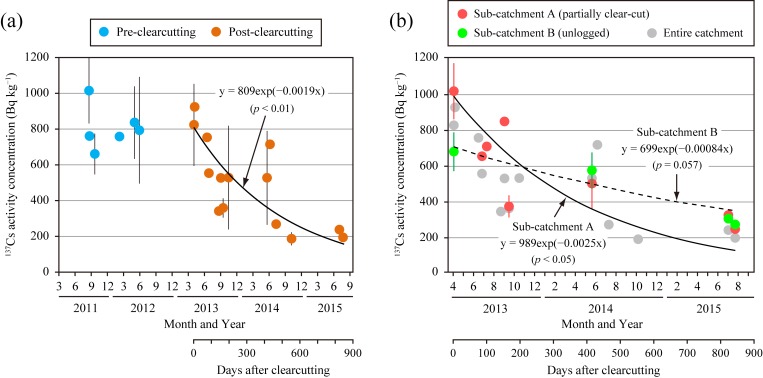
Temporal variation in 137Cs activity concentrations in suspended solids at the outlets of (a) the entire catchment during the study period and (b) the sub-catchments and entire catchment during the post-clearcutting period. The means (n = 1–7) of each rainfall event are plotted with the standard deviations (error bars).